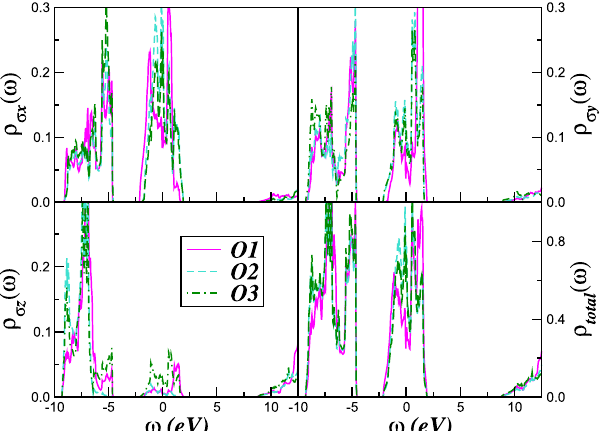
Figure 2. Orbital resolved and total LDA density-of-states (DOS) for the three inequivalent oxygen atoms in the ε -phase. Notice that all bands as well span over the Fermi level. Also relevante is the evolution of the electronic DOS at different